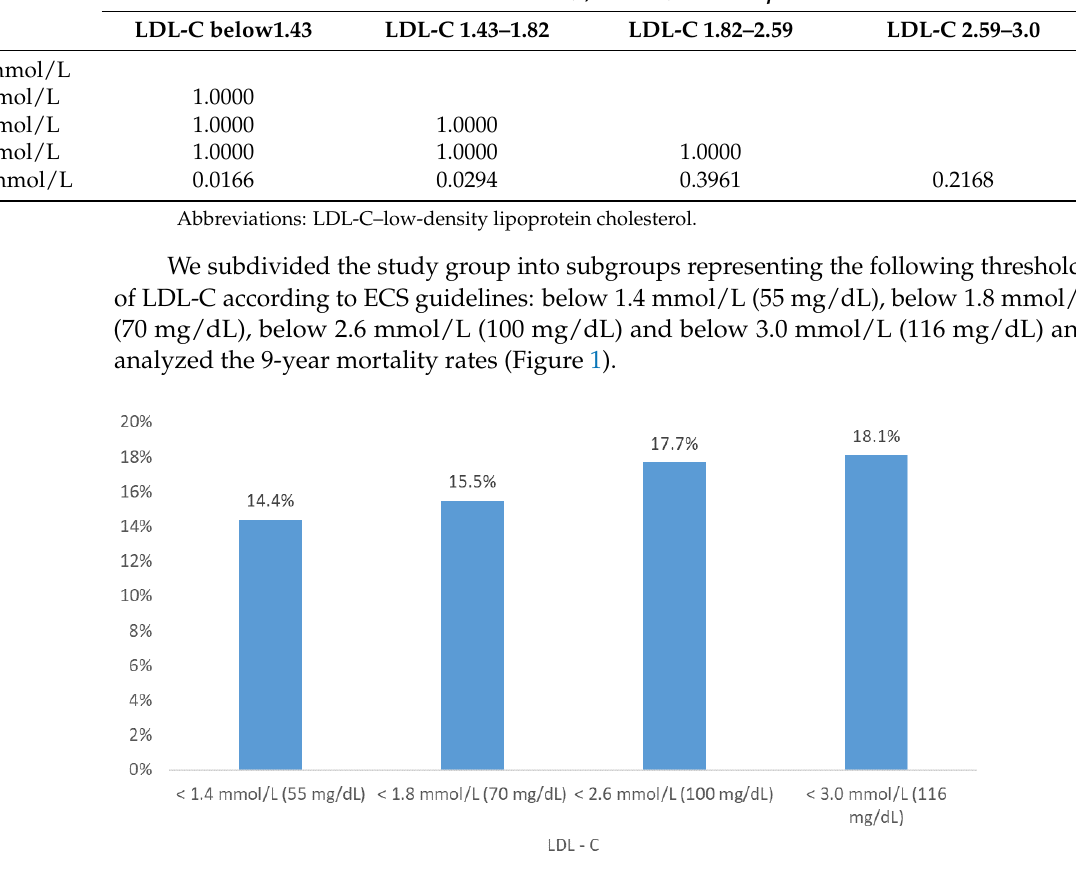
Figure 1. Nine-year cumulative mortality in subgroups divided according to ECS cardiovascular LDL-C threshold.